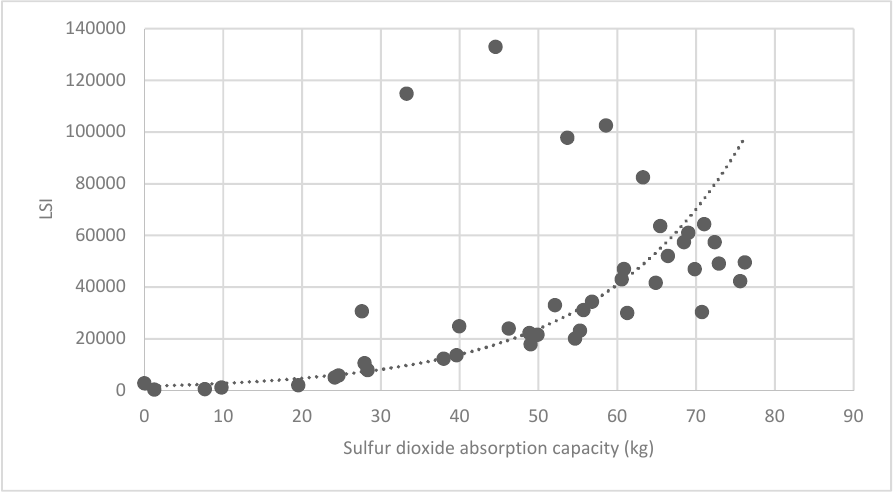
Figure 29. Association between brush LSI and sulfur-dioxide absorption capacity.